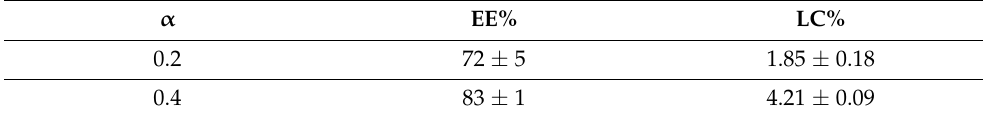
Table 4. Encapsulation efficiency, EE%, and loading capacity, LC, of doxorubicin in the (TEAC 12 ) 4 / DOPE liposomes. T = 277 K. Three independent experiments were carried out for each system